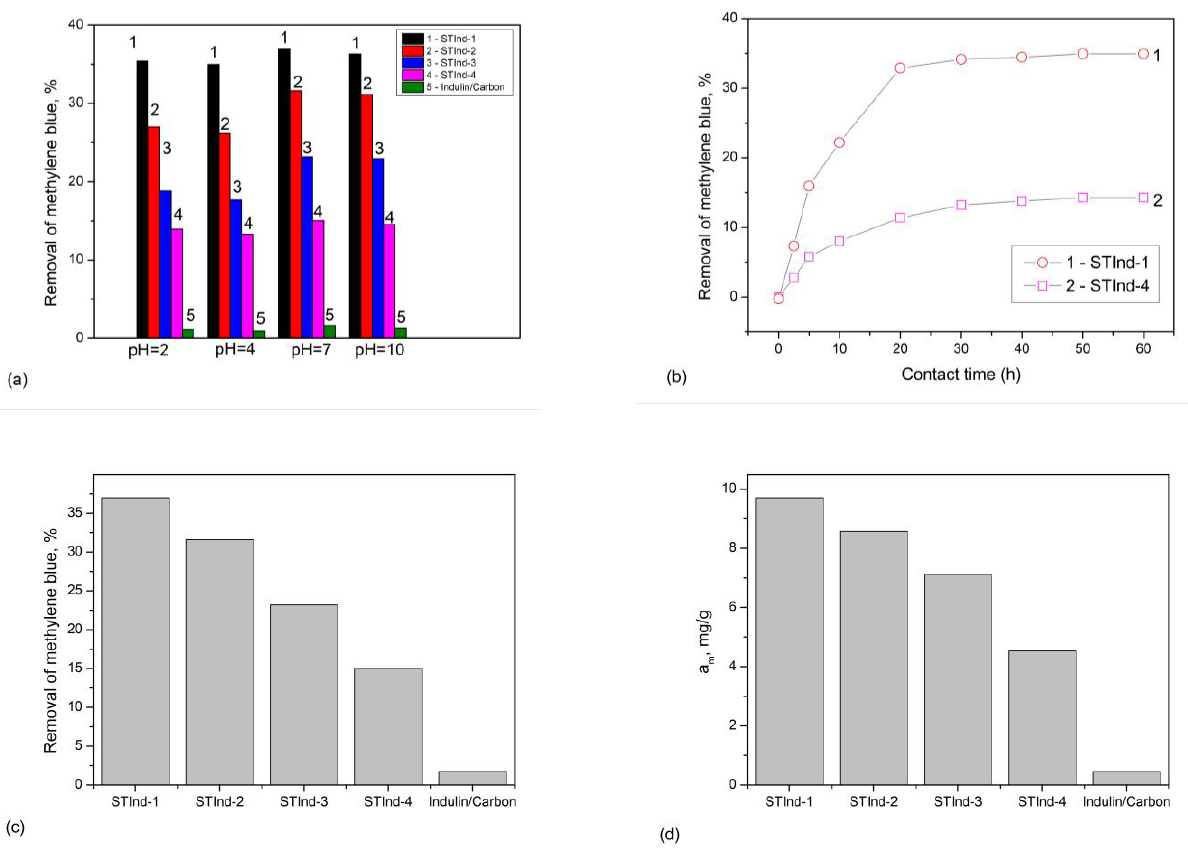
Figure 5. The effect of ( a ) pH (C 0 = 12.8 mg/L, pH = 2, 4, 7), ( b ) contact time C 0 = 12.8 mg/L, pH = 7), ( c ) the percent of methylene blue removal (C 0 = 12.8 mg/L, pH ~7) and ( d ) maximum adsorption (a m ) (mg/g) for the investigated adsorbents. Table 5. Parameters of modified Langmuir and Freundlich isotherms for methylene blue adsorption on